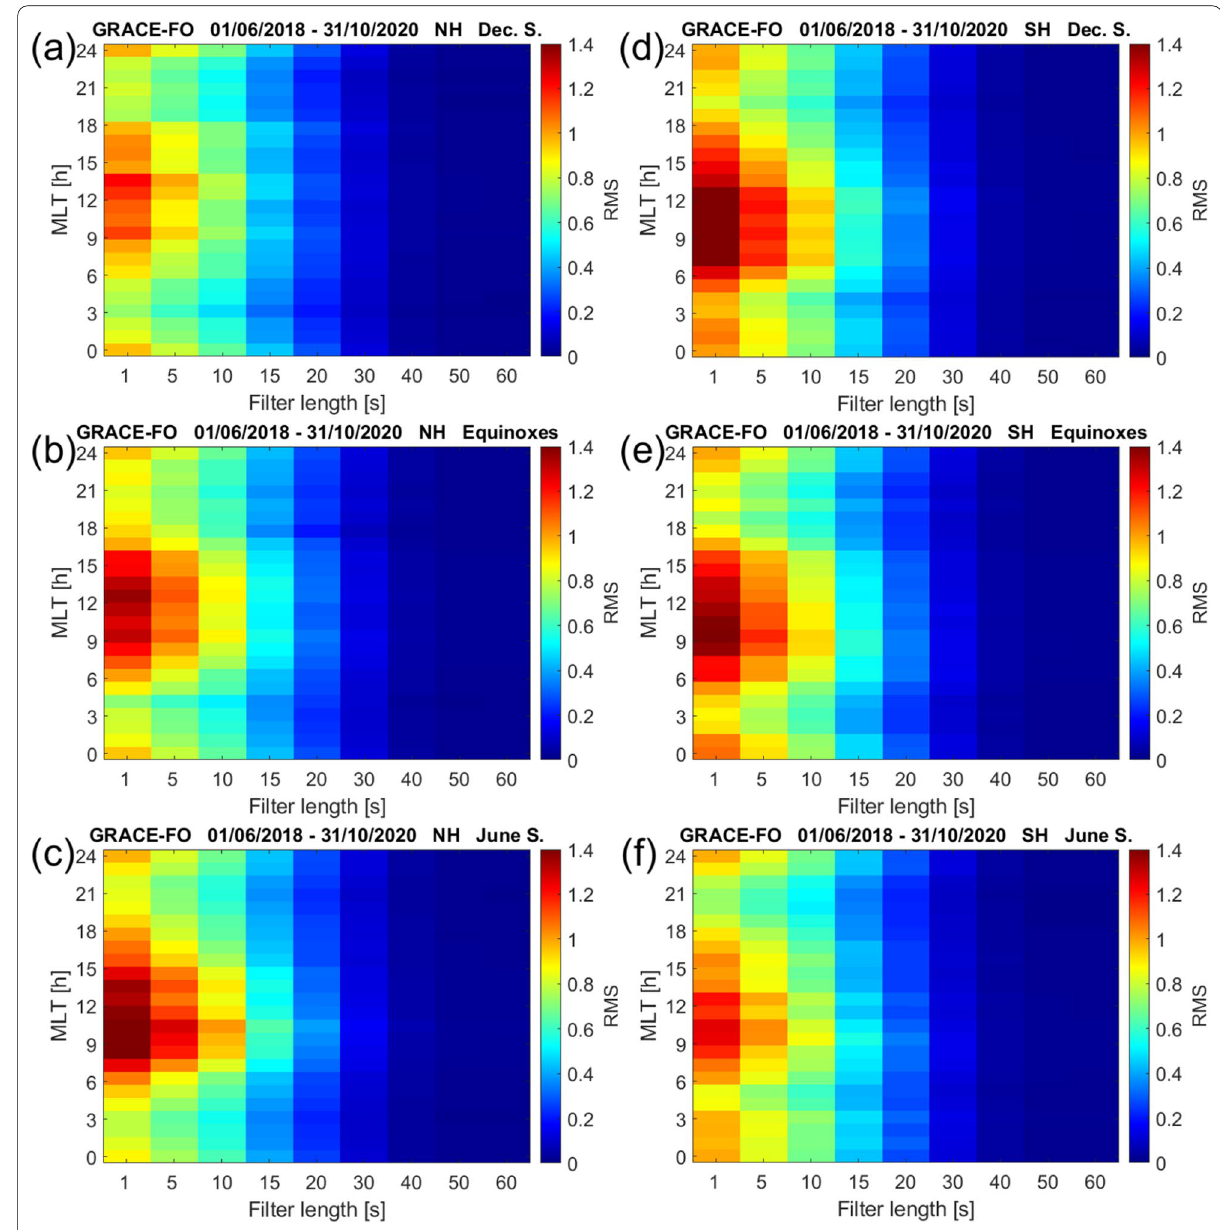
Fig. 11 Similar as Fig. 10, but for the RMS of small-scale